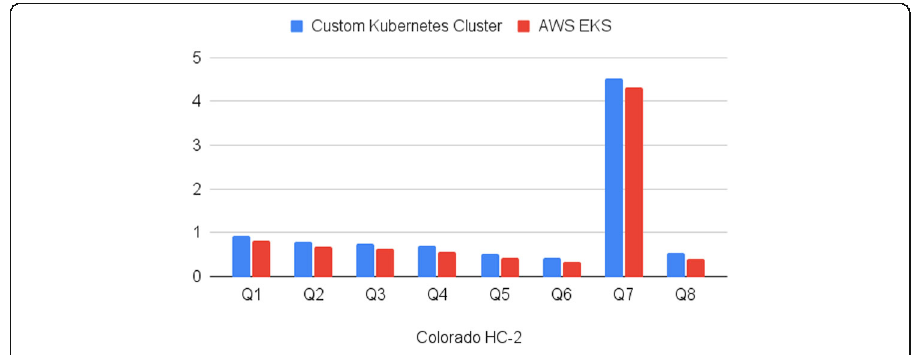
Fig. 16 Query execution time for AWS EKS vs local Kubernetes cluster for Colorado HC-2